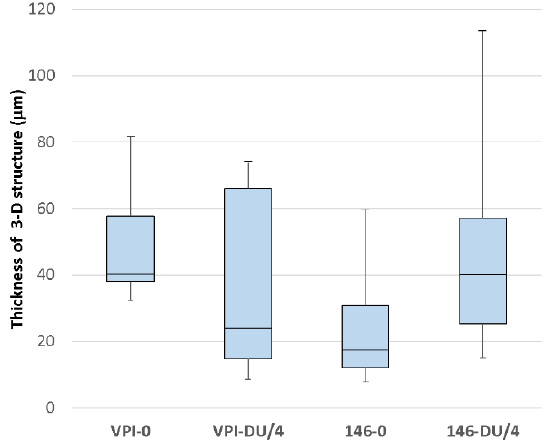
Figure 8. Thickness of bacterial 3-D structure of VPI 10463 (VPI) and CD17-146 (146) in cecum of mono-associated mouse model treated with placebo or with a quarter of usual dose of MTZ. The thickness of the bacterial 3-D structure is defined by the height on which bacteria are distributed. The thickness was determined directly from confocal Z-stack images. At least three mice were used for CLSM analyses for each strain, and at least 8 fields per sample were observed. Data are presented as boxplots with median and minimum-maximum whiskers. No significant difference was observed between strains (Mann-Whitney test).